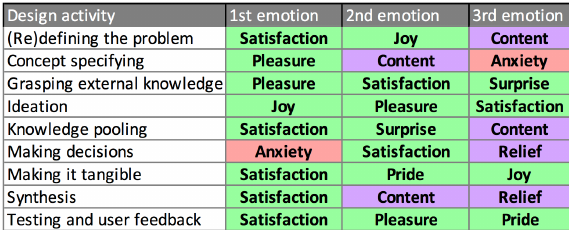
Table 2. Top three emotions associated with individual design activities